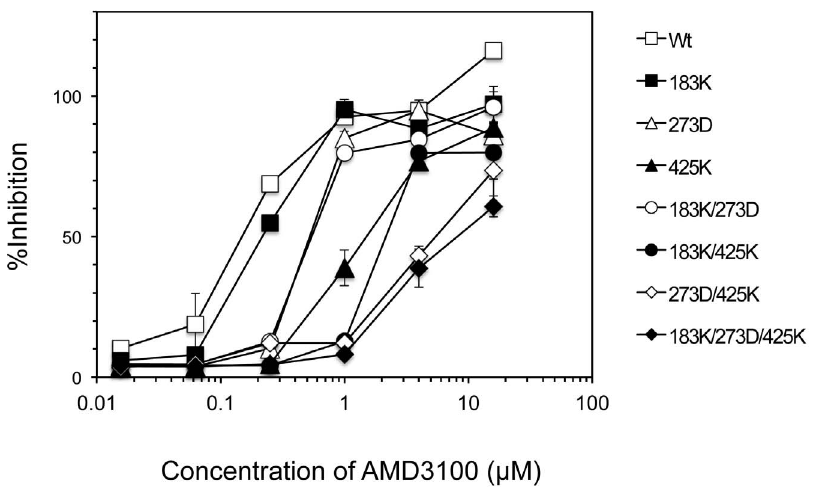
Figure 4. Susceptibilities of replication-competent recombinant viruses. SupT1/CCR5 cells were infected with the same amount of replication-competent recombinant viruses carrying mutations (100 TCID 50 ) in the presence of various concentrations of AMD3100, and then cultured for 6 days. Cytopathic effects were determined by an MTT assay. Data are the means 6 SD of triplicate experiments. doi:10.1371/journal.pone.0089515.g004 (Table 2). In single mutants, N273D and M425K substitutions conferred reduced sensitivity to AMD3100 (4.1-fold and 2.6-fold,